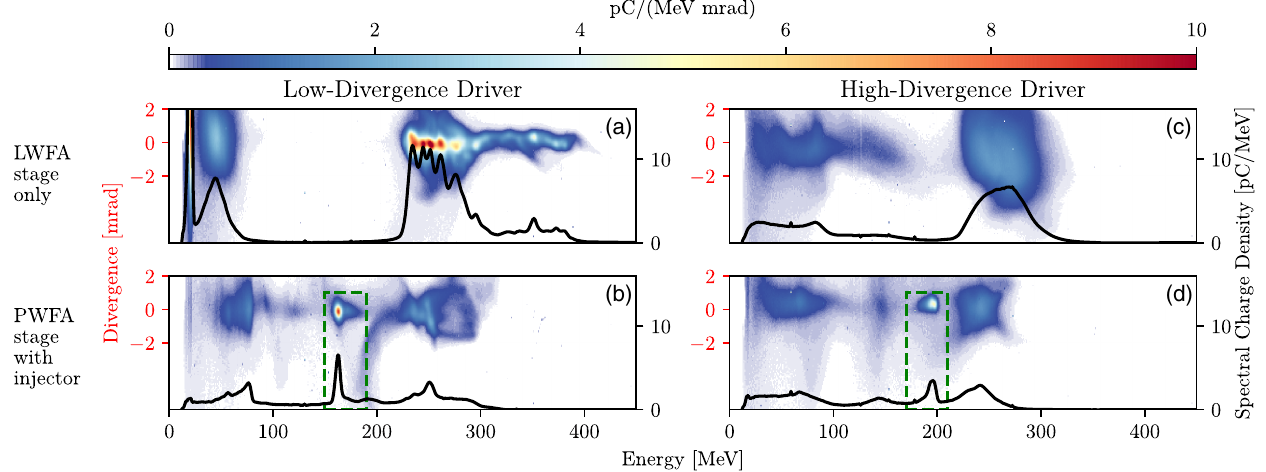
FIG. 4. Increase of angular-spectral charge density in the PWFA stage. (a) Typical spectrum of a low-divergence LWFA-generated drive beam with 640 pC bunch charge in the high-energy feature and an average divergence of 0.41 mrad (rms of super-Gaussian fit), leading to an angular-spectral charge density of 5 pC = ð MeV μ sr Þ . (b) Spectrum after the PWFA stage with optimized beam loading for high charge density of the witness beam. Because of the lower divergence of 0.28 mrad (rms of super-Gaussian fit) of the 30 pC witness beam, its angular-spectral charge density is 40% higher than the driver [ 7 pC = ð MeV μ sr Þ ]. (c) Typical LWFA-driver spectrum for the high-divergence case (1.2 mrad, rms of super-Gaussian fit). Using this beam with a charge of 400 pC and an angular-spectral charge density of only 0 . 4 pC = ð MeV μ sr Þ , a witness beam (d) with 0.22 mrad rms divergence, 20 pC charge, and an angular-spectral charge density of 6 pC = ð MeV μ sr Þ is